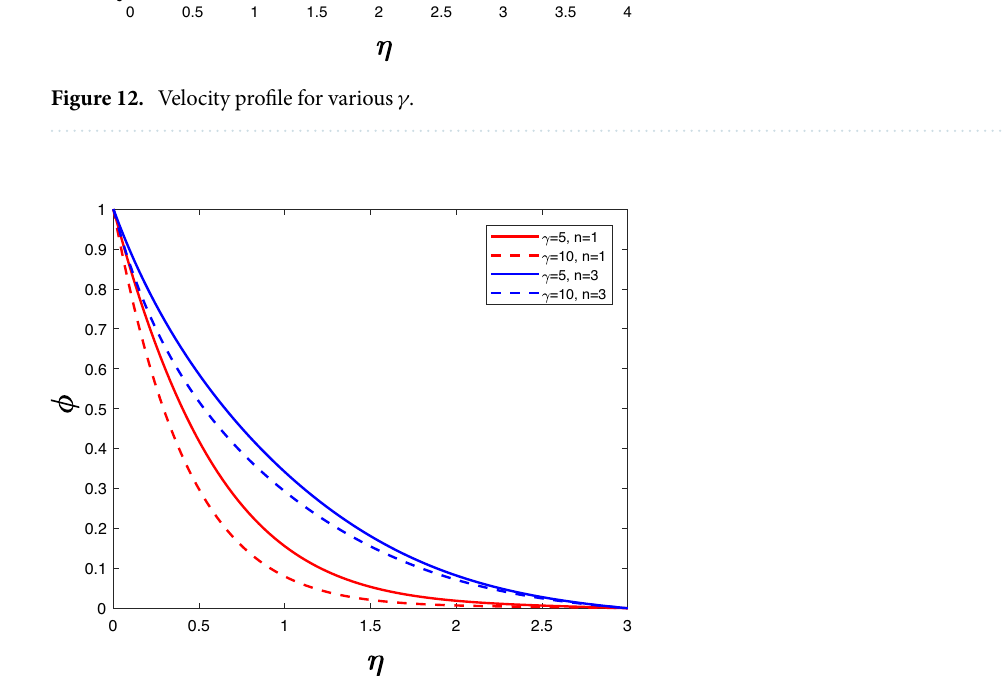
Figure 13. Concentration profile for various γ